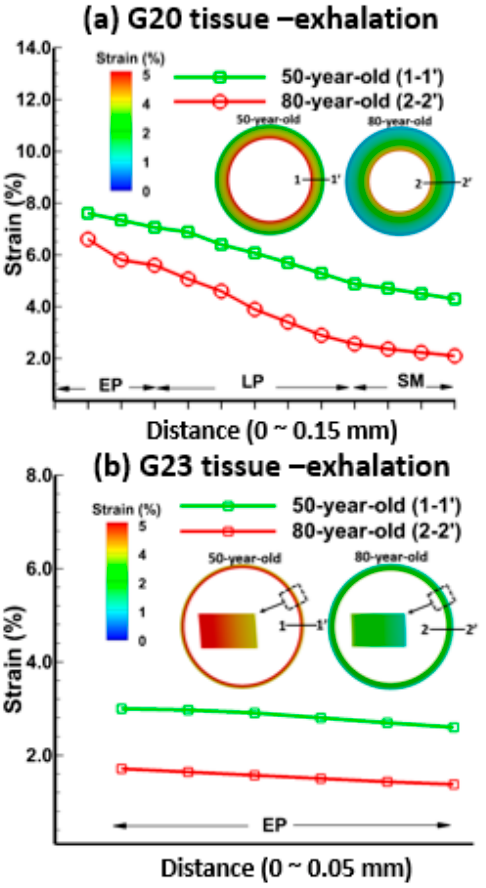
Figure 5. Tissue strain distributions during mid ‐ point of exhalation (t = 1.2 s) for the 50 ‐ year ‐ old and the 80 ‐ year ‐ old at each layer—epithelium, lamina propria, and smooth muscle—of ( a ) the bronchiole (G20); and the epithelium of ( b ) the alveolar sac (G23).